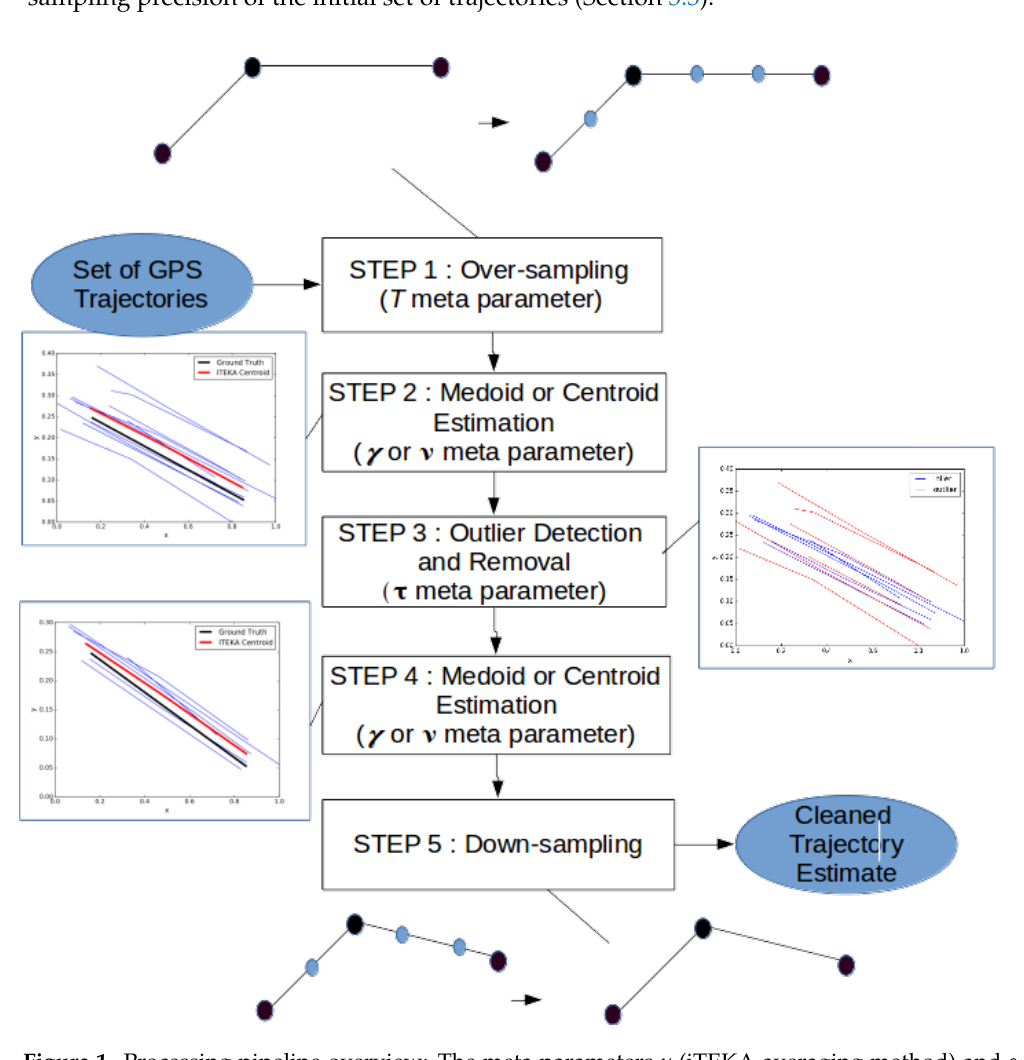
Figure 1. Processing pipeline overview: The meta parameters ν (iTEKA averaging method) and γ (soft-DTW averaging method) are defined, respectively, in Equations (5) and (8). The T meta parameter is the length of the trajectories when they have been over-resampled during the pre-processing step and is defined in Section 3.1. The τ parameter is a threshold involved to decide whether a trajectory is an outlier and is defined in Section